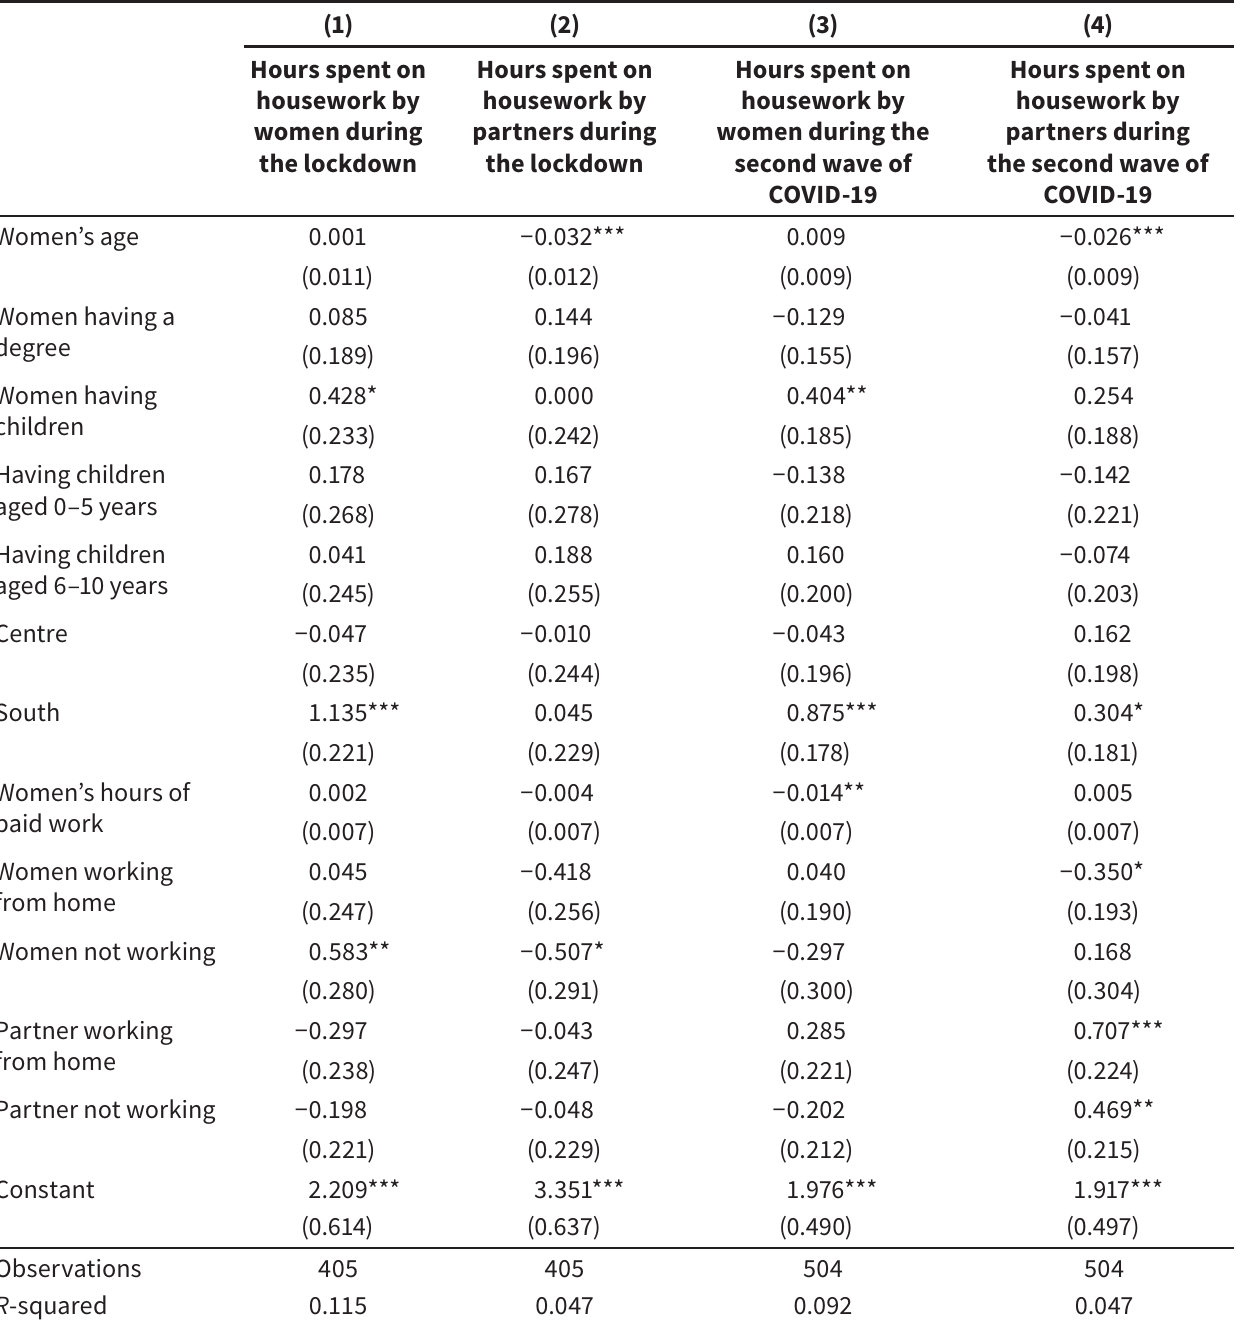
Table 3 Multivariate regression model of hours spent on housework by women and their partners during the first and second waves of